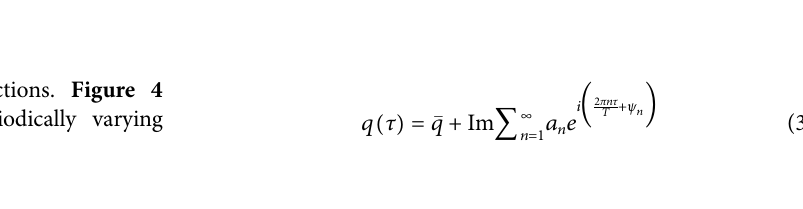
Frontiers in Energy Research |